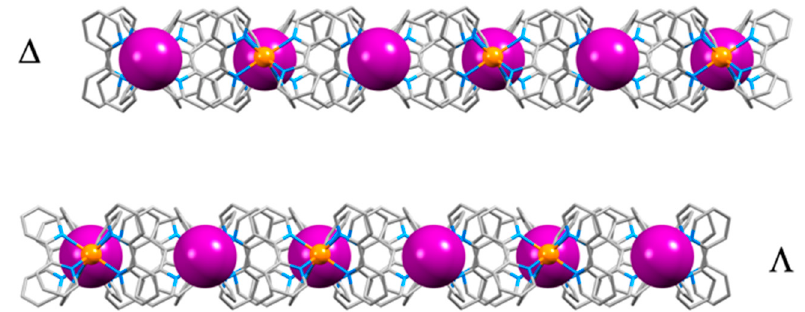
Figure 8. Unless the [M(bpy) 3 ] n + cations in the Structure Type 1 complexes are homochiral, alternating homochiral sheets have opposite ∆ and Λ chiralities, as seen in [Li(bpy) 3 ]I · bpy (Refcode REXVOF) [92] (Li, orange; I violet).